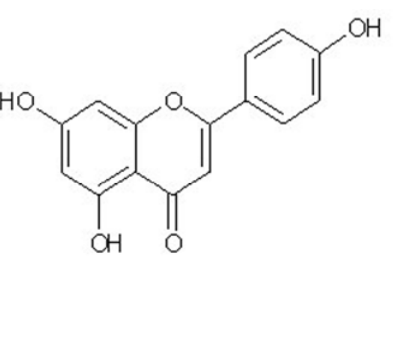
Figure 1. Structure of